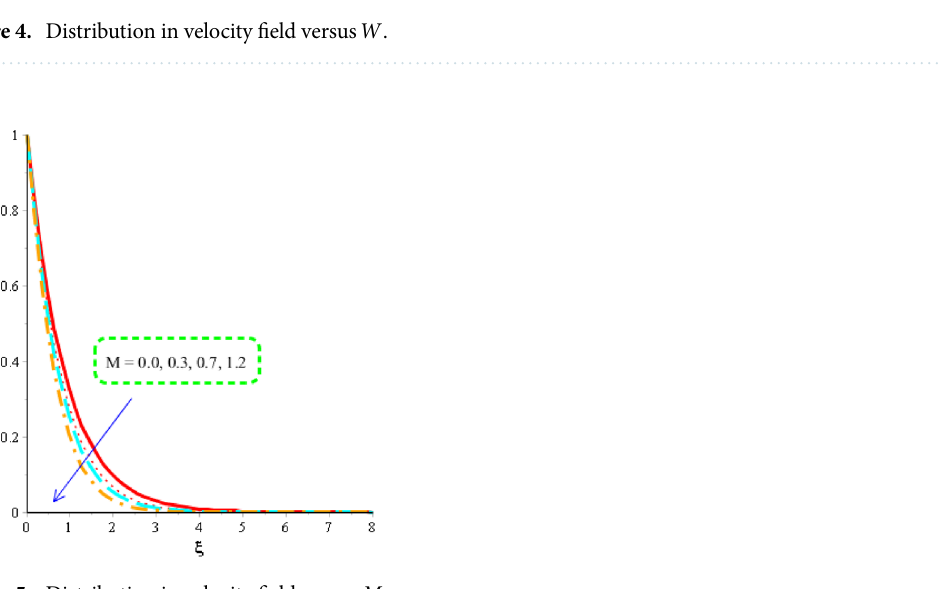
Figure 5. Distribution in velocity field versus M